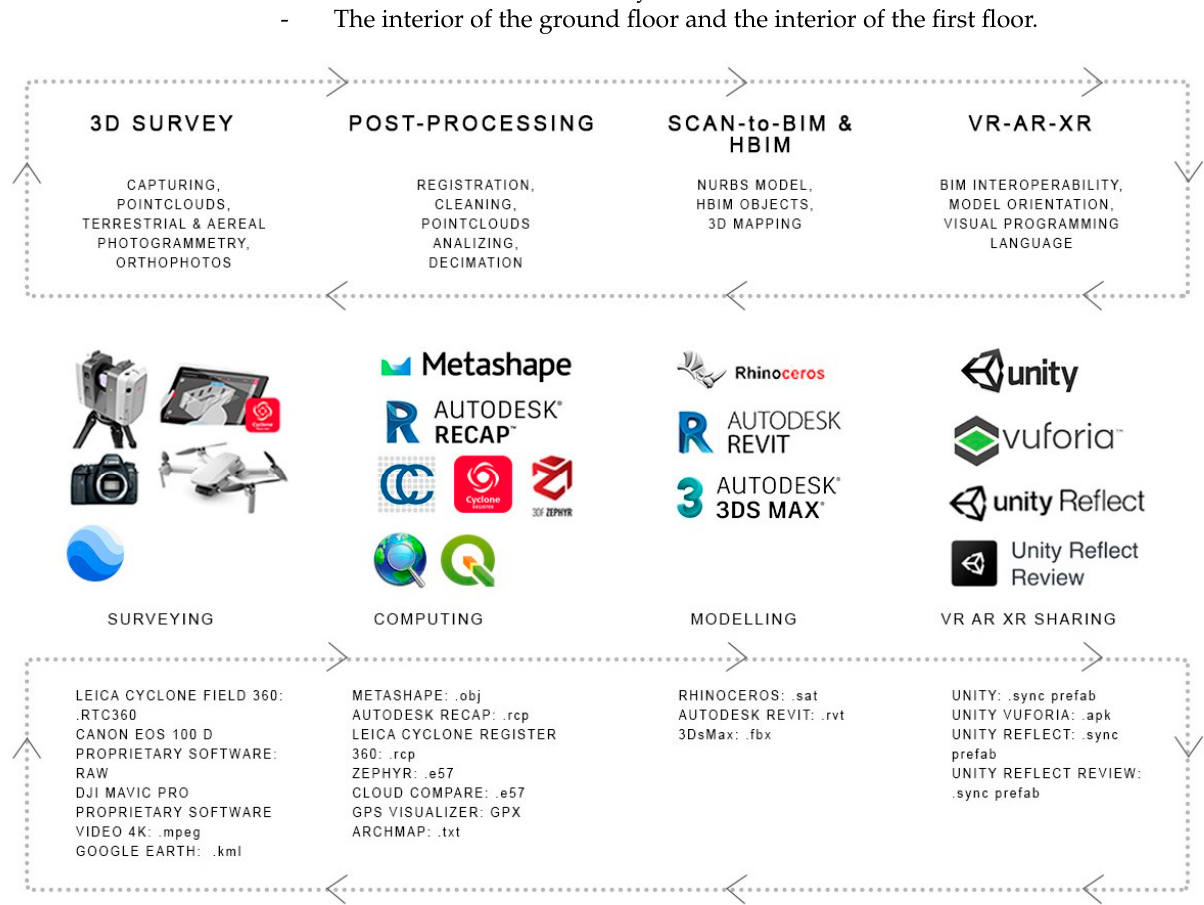
Figure 4. The workflows explored in this process, from digital survey to digital modelling and annotation in Unity Reflect.